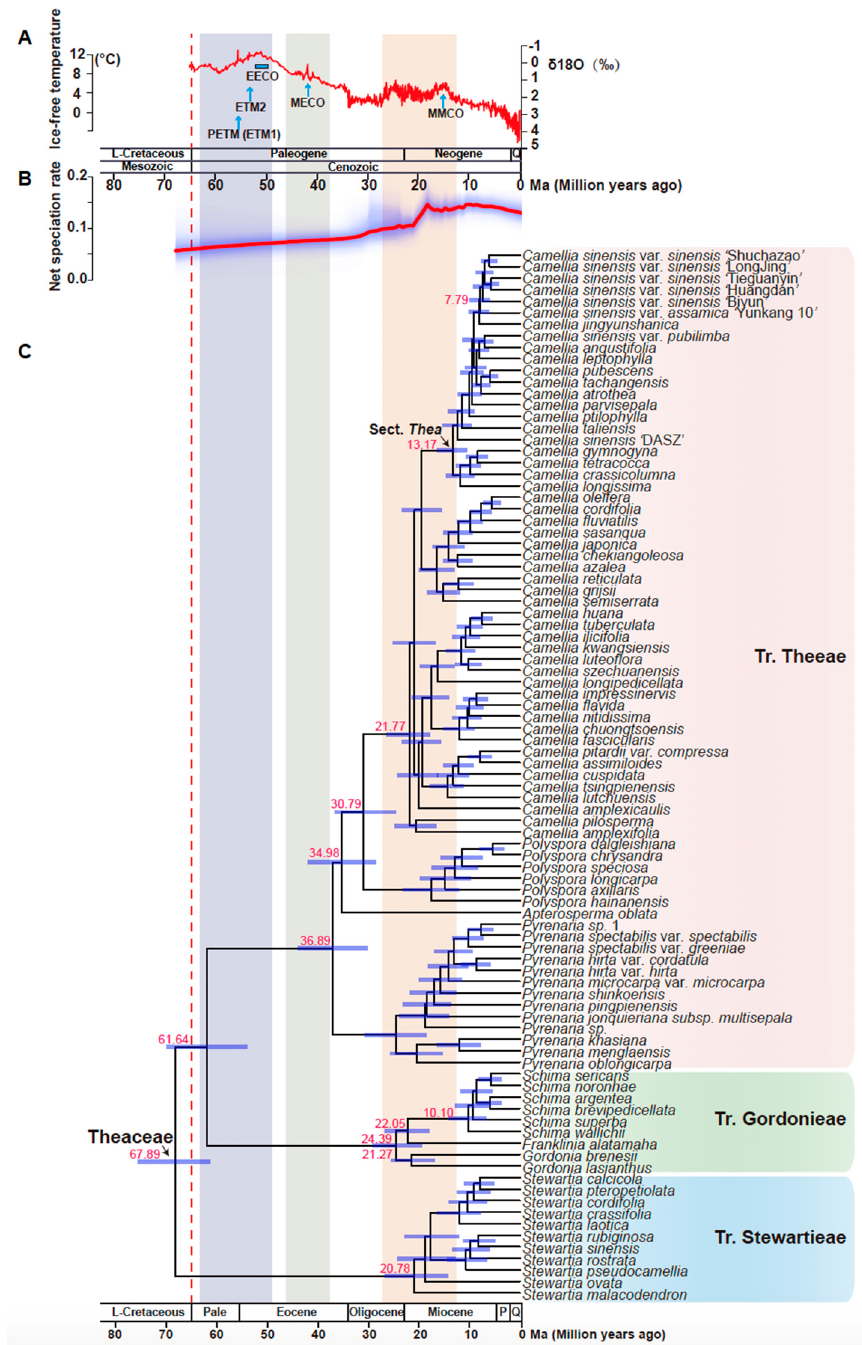
Figure 6. Chronogram of Theaceae estimated using a Bayesian relaxed molecular clock: ( A ) The global climate curve over the last 65 million years (modified from Zachos et al., 2008 [65] and Guo et al., 2020 [66]). Time periods of major climatic events are highlighted. EECO, Early Eocene Climatic Optimum; MECO, Mid-Eocene Climatic Optimum; MMCO, Mid-Miocene Climatic Optimum; PETM (ETM1), Paleocene Eocene Thermal Maximum 1; ETM2, Eocene Thermal Maximum 2. ( B ) Rate-through-time plot of Theaceae. The red line is the median diversification rate (species/million years) and the blue shadow indicates the 95% credibility interval. ( C ) A chronogram (timed phylogeny) of Theaceae. This time tree results from MCMCTree analysis using the model tree from six low copy coalescent trees. Red numbers represented node age. Tribes are listed on the right of the species’ names. The dashed red line indicates the Cretaceous-Paleogene (K-Pg) boundary. Light-blue bars indicate 95% credibility intervals of the divergence times. The geological timescale at the bottom is in million years. L-Cretaceous, Late Cretaceous; Pale, Paleocene; P, Pliocene; Q, Quaternary.